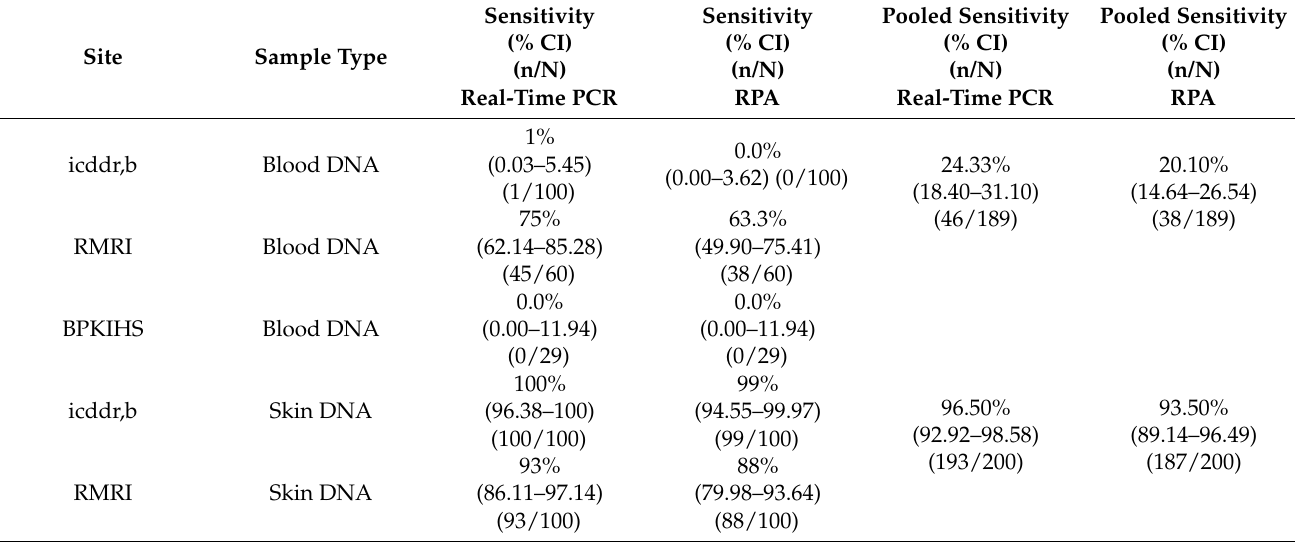
Table 2. Clinical sensitivity of both real-time PCR and LD RPA assay using blood and skin samples of PKDL patient from three centers in Bangladesh, India,